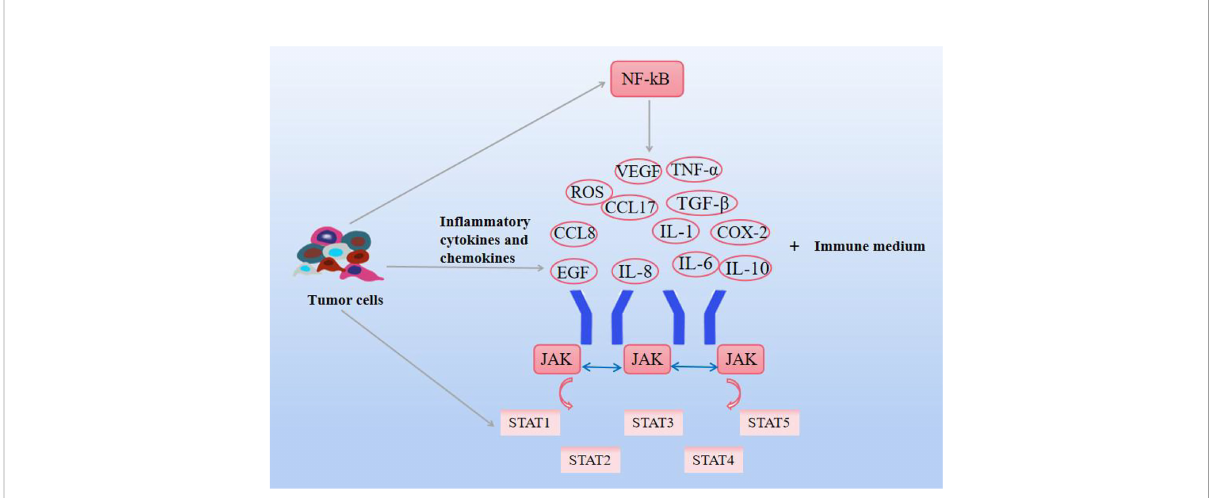
FIGURE 4 Effects of natural compounds on in fl ammation and related pathways. In fl ammatory cytokines and chemokines themselves, as well as JAK-STAT and NF-KB signaling pathways, interact to promote cancer cell